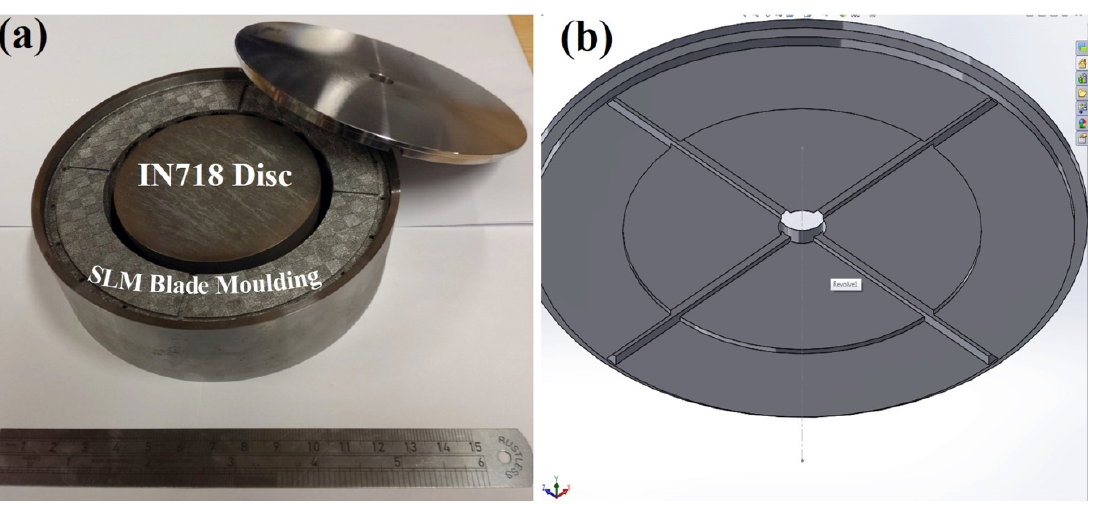
Figure 4. ( a ) An image of the parts including IN718 inserted disk; ( b ) Computer-aided Design (CAD) model of a modified can lid.